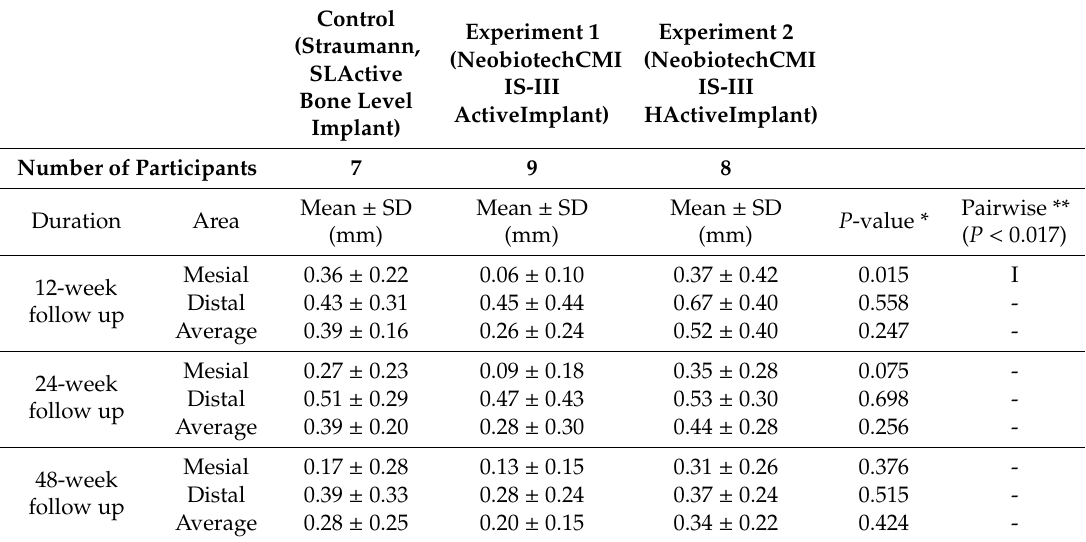
Table 2. Comparison of marginal bone loss among three di ff erent types of